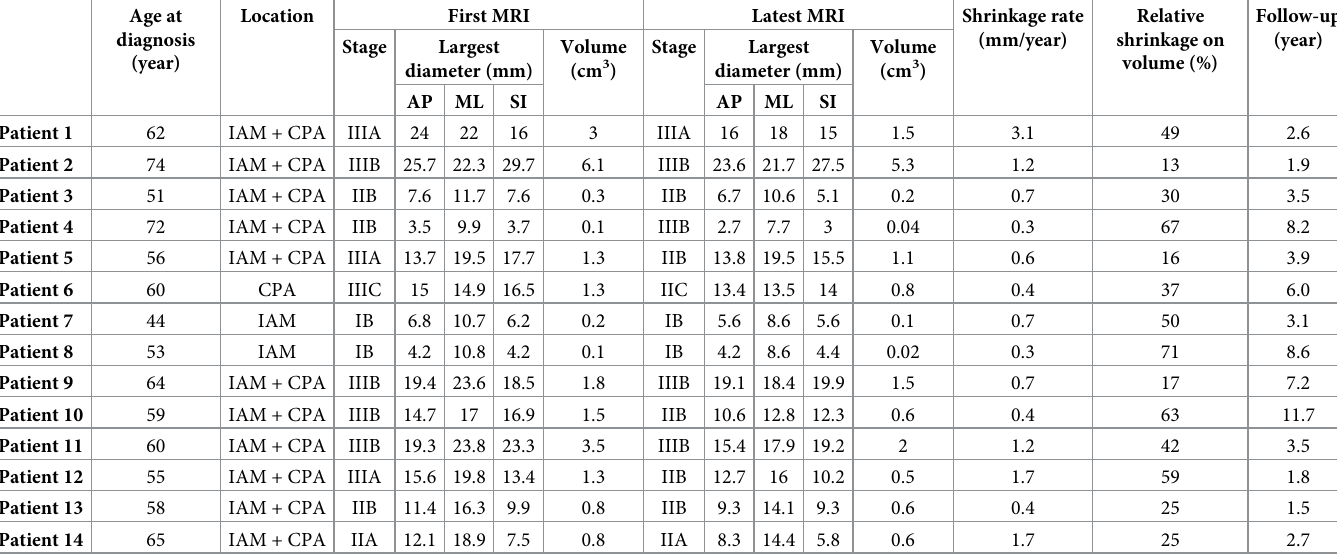
Table 1. MRI measures for each